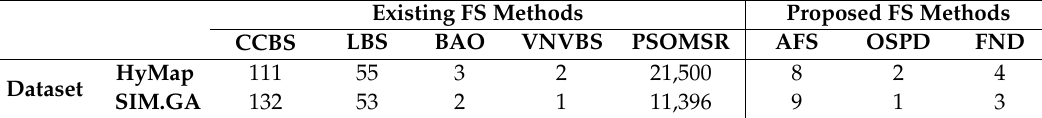
Table 4. The time in seconds spent by the feature selection (FS) methods to select optimal